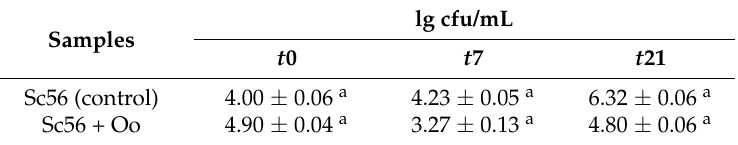
Table 7. B. bruxellensis Unifg 8 cell count (cfu/mL) on WLN agar medium from grape musts inoculated with different combinations of S. cerevisiae KT029756 or co-inoculated with S. cerevisiae KT029756/ O. oeni Unifg 21 during AF: t 0, day of inoculation; t 7, 7 days from the inoculation; t 21, 21 days from the inoculation. Results of the ANOVA analysis are shown as letters on the data corresponding to the B. bruxellensis cell count: different letters on the same column indicate significant differences of